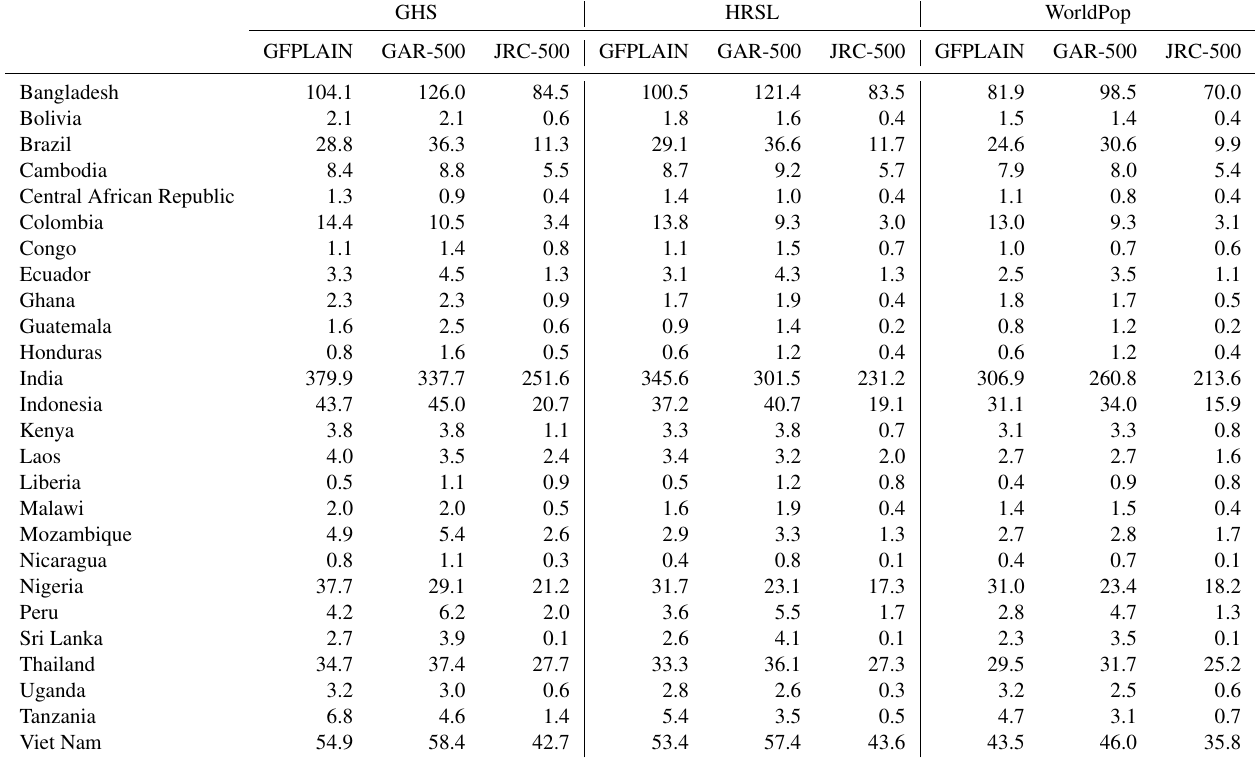
Table A9. Population estimates within flood-prone areas (millions) intersecting GFPLAIN, GAR-500, and JRC-500 with GHS, HRSL, and WorldPop for 26